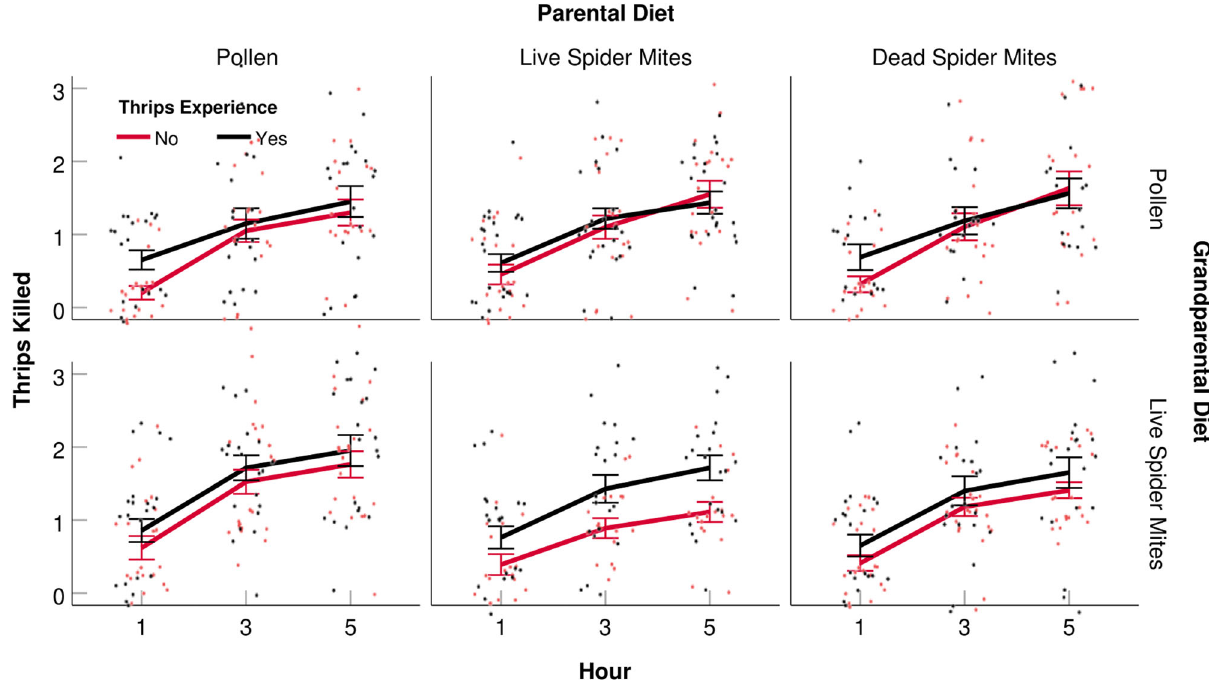
Fig. 4 Predation rate over time. Number (mean ± SE and individual datapoints) of 1st instar thrips, F. occidentalis , killed by single mated A. swirskii females inside acrylic cages within 1, 3, and 5 h. Predatory mite females had experienced thrips early in life or not ( + or − ) and were the progeny of parents fed Typha pollen (P), life spider mites (L), or dead spider mites (D), and grandparents fed Typha pollen (P) or live spider mites (L). The numbers of replicates ( n ; independent experimental animals) within treatments (sequence in treatment acronyms is grandparental diet, parental diet, early life experience by progeny) are 21 (LP + ), 20 (LP − ), 21 (LL + ), 18 (LL − ), 20 (LD + ), 22 (LD − ), 20 (PP + ), 19 (PP − ), 23 (PL + ), 20 (PL − ), 16 (PD + ), 19 (PD − ). Thrips experience had a signi fi cant effect (GEE, P < 0.05; see Table 2 for complete statistical results).